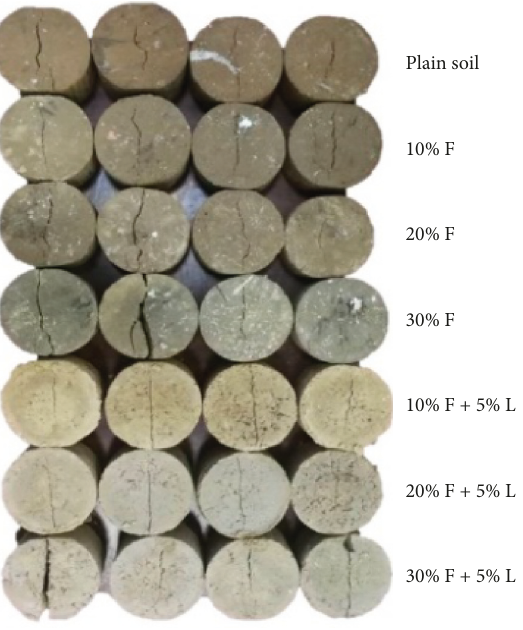
Figure 15: Failure patterns of soil samples.